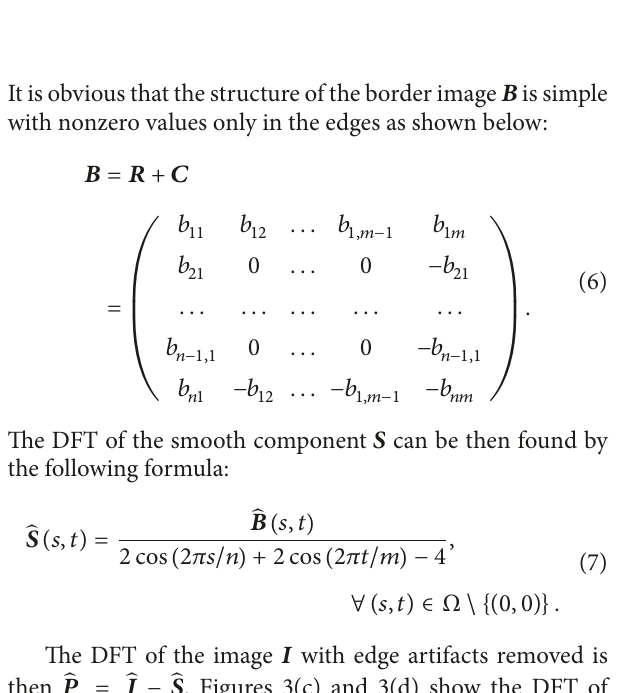
Figure 4: A top-level architecture for OPSD using two FPGAs and a host PC connected over a high-bandwidth bus. The steps are associated with Algorithm